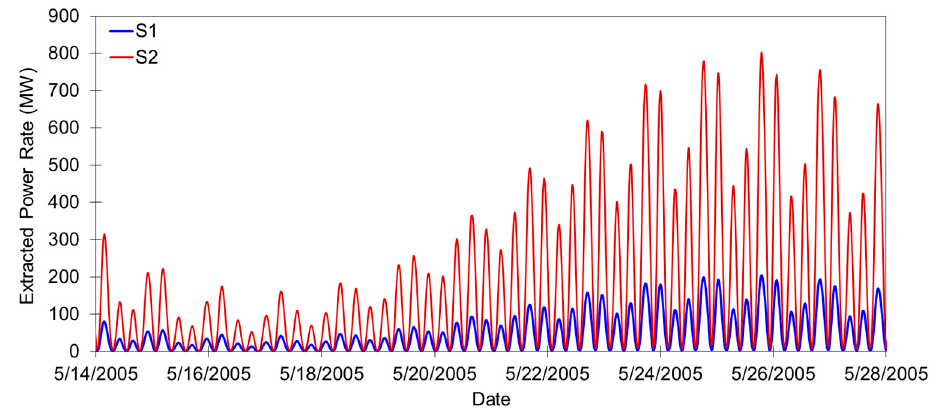
Figure 13. Time series of extracted power rate for two hypothetical tidal turbine farm scenarios (S1 and S2).